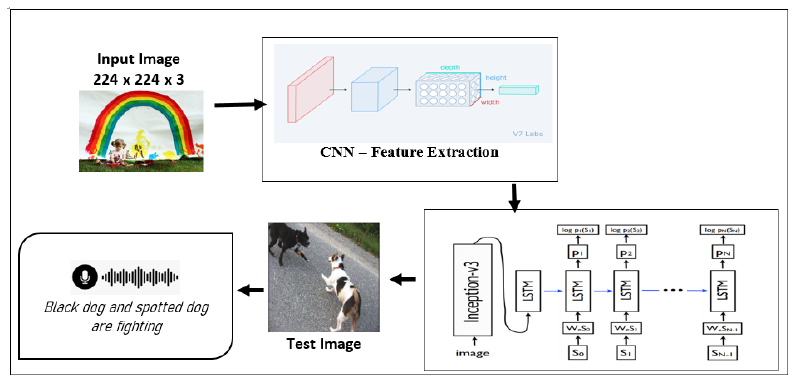
Figure 5. CNN-LSTM Design.